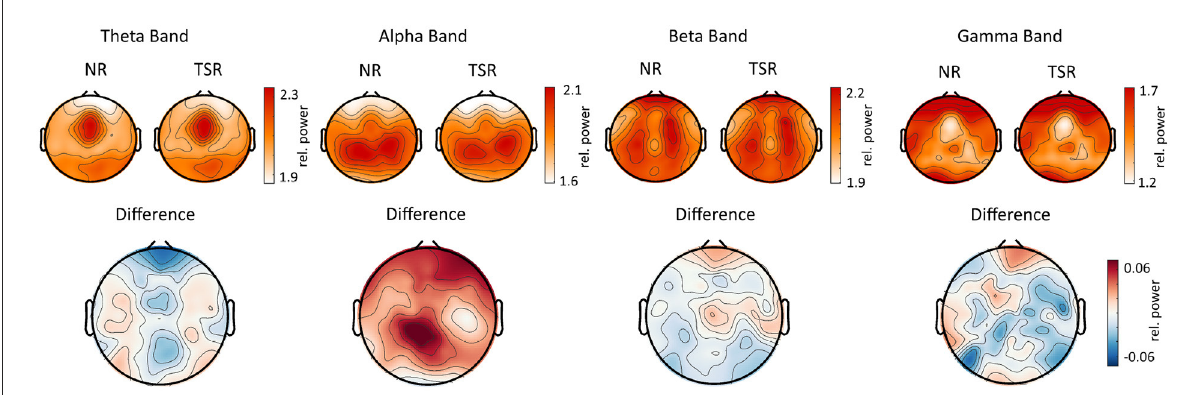
FIGURE4 Topographical plots showing the mean EEG activity across all subjects from ZuCo 2.0. Averaged sentence level features are plotted in each reading condition as well as the difference between the tasks (NR minus TSR; scalp viewed from above, nose at the top). Only for the purpose of this visualization, relative power values are plotted (i.e., power in each frequency band divided by the average power between 1 and 50Hz), showing the expected typical power distribution across the